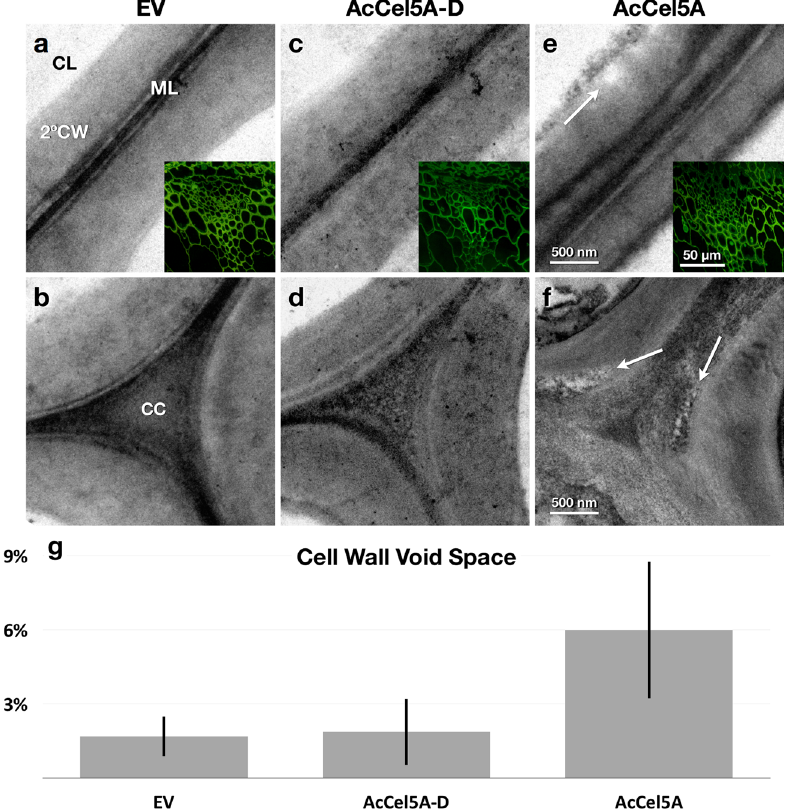
Figure 4. Microscopic analysis of cell walls. Transmission electron micrographs (TEM) of interfascicular fiber cell walls and confocal scanning laser micrographs (CSLM) of vascular bundles sectioned and images in transverse section. The confocal scanning laser micrographs CSLM images (insets) of the empty vector control ( a ), AcCel5A catalytically inactive ( c ), and AcCel5A expressing ( f ) plants display largely the same cell and tissue morphology around the vascular bundles with no obvious evidence for xylem collapse or occlusion, or other signs of cell wall weakening. The TEM micrographs; however, reveal differences among the samples. The AcCel5A expressing cell walls displayed more irregular surfaces and regions of clearing or low density ( e , f arrows). The % void space within the cell walls was measured by image analysis of the TEM micrographs are presented ( g ). Error bars show standard deviation. CL-cell lumen, 2°CW-secondary cell wall, ML-middle lamella, CC-cell corner. The AcCel5A-D data is from line 37-4-a and the AcCel5A data is from line